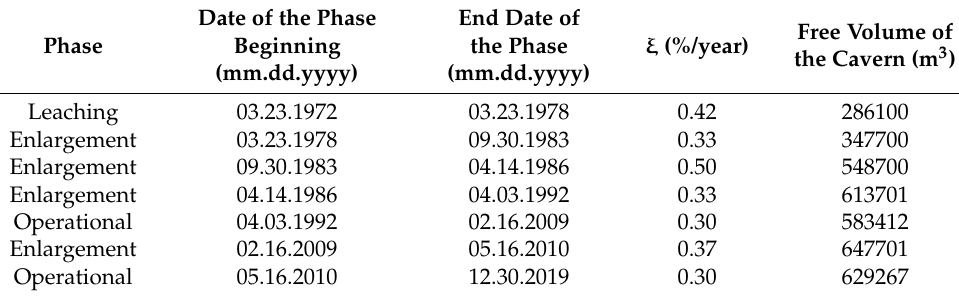
Table 3. Data characterising the individual production phases for the S_014